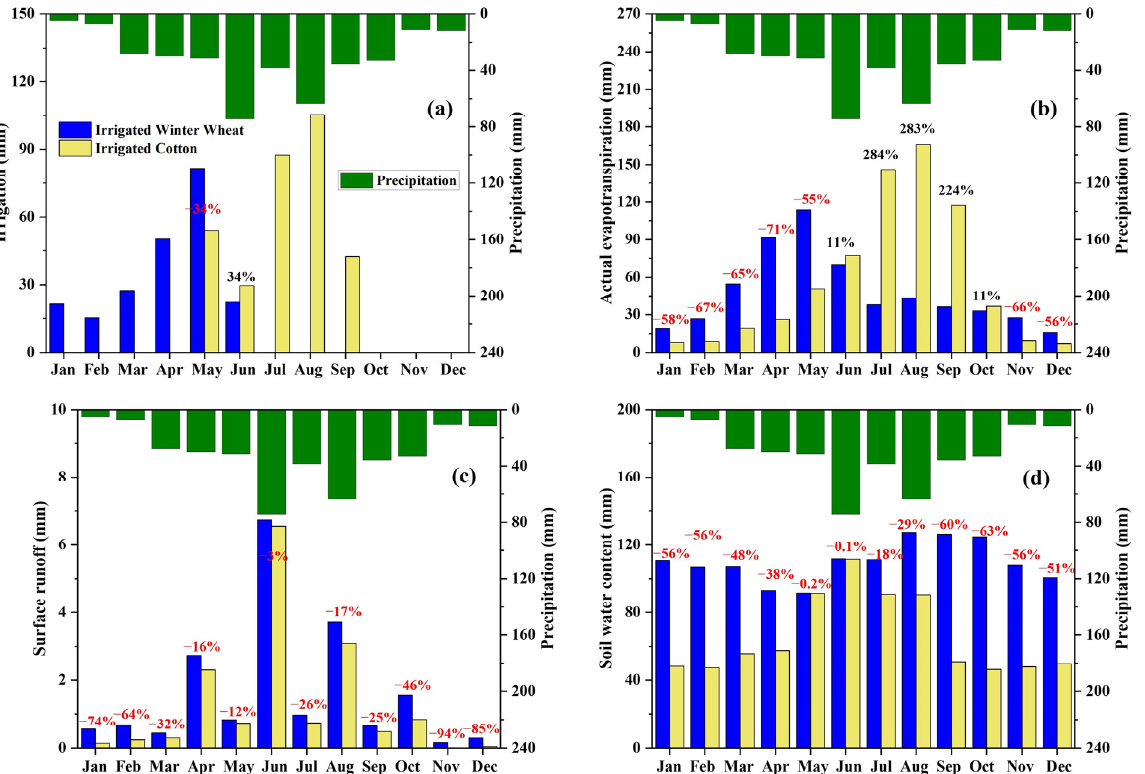
Figure 6. Monthly comparison of hydrologic parameters (mm) under the baseline irrigated winter wheat and the land-use change scenario of irrigated cotton in the Palo Duro watershed. Irrigation ( a ), actual evapotranspiration ( b ), surface runoff ( c ), and soil water content ( d ). Under dryland conditions, year-round precipitation was the same for winter wheat and cotton land uses. Results have shown that the ET a was increased evidently in June, July, August, and September by 21%, 82%, 51%, and 25%, respectively, for dryland cotton relative to the dryland winter wheat (Figure 7a). Nevertheless, the ET a reductions were discovered from October to May with a range of 16% to 61%. A good response of surface runoff to rainfall distribution was detected under rainfed land uses (Figure 7b). The decreases in surface runoff changed from 1% to 83% under the dryland cotton land use compared to the dryland winter wheat, except for a 5% increase in June. Under cotton land use, the distinctly different growing period was the dominant reason for the decreased surface runoff. The majority of rainfall was allocated in the cotton-growing season, and the established ground cover was in favor of a decrease in surface runoff generation. With the exception of May (13% increase), the soil moisture reductions varied from 5% to 78% when the replacement of dryland winter wheat was with dryland cotton (Figure 7c).